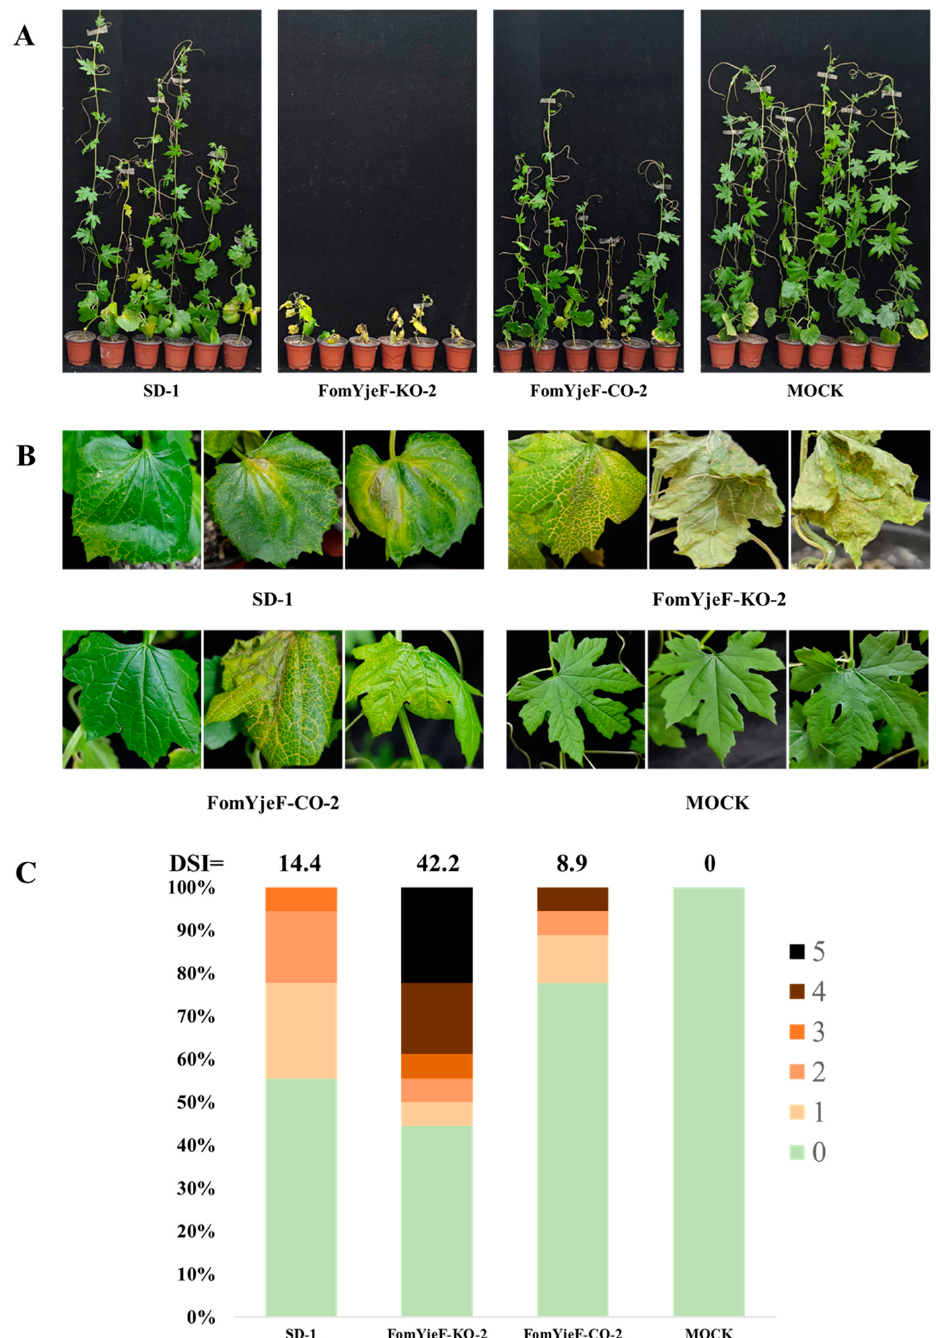
Figure 4. FomYjeF regulated the pathogenicity of F. oxysporum f. sp. momordicae . ( A ) The wild-type strain SD-1, FomYjeF-KO-2, and FomYjeF-CO-2 were inoculated to bitter gourd plantlets at the two-leaf stage for 28 days. As the control, MOCK was inoculated with sterile water. ( B ) Yellow symptoms in the leaf veins of bitter gourd. ( C ) Disease severity index (DSI) of bitter gourd plants inoculated with SD-1 and mutant strains. The disease severity was recorded using a scale ranging from 0 to 5, with 0 for healthy plants and 5 for dead